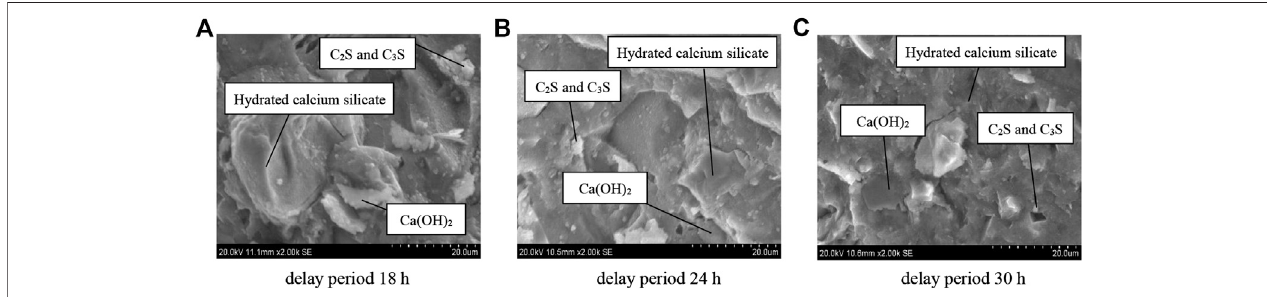
Figure 10 | SEM image of hydration products at 90 days age under different delay period. (A) delay period 18 h. (B) delay period 24 h. (C) delay period 30